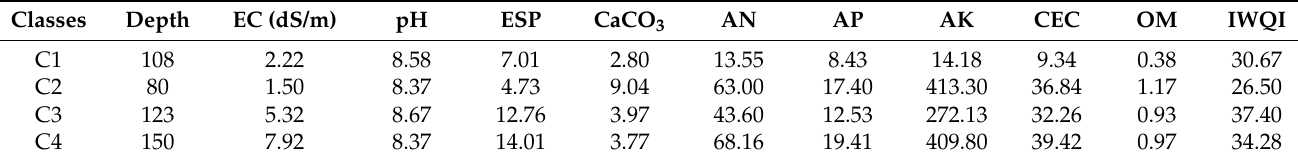
Figure 7. Land capability classes within study area. Table 3. Statistical summary of soil properties in the four land capability